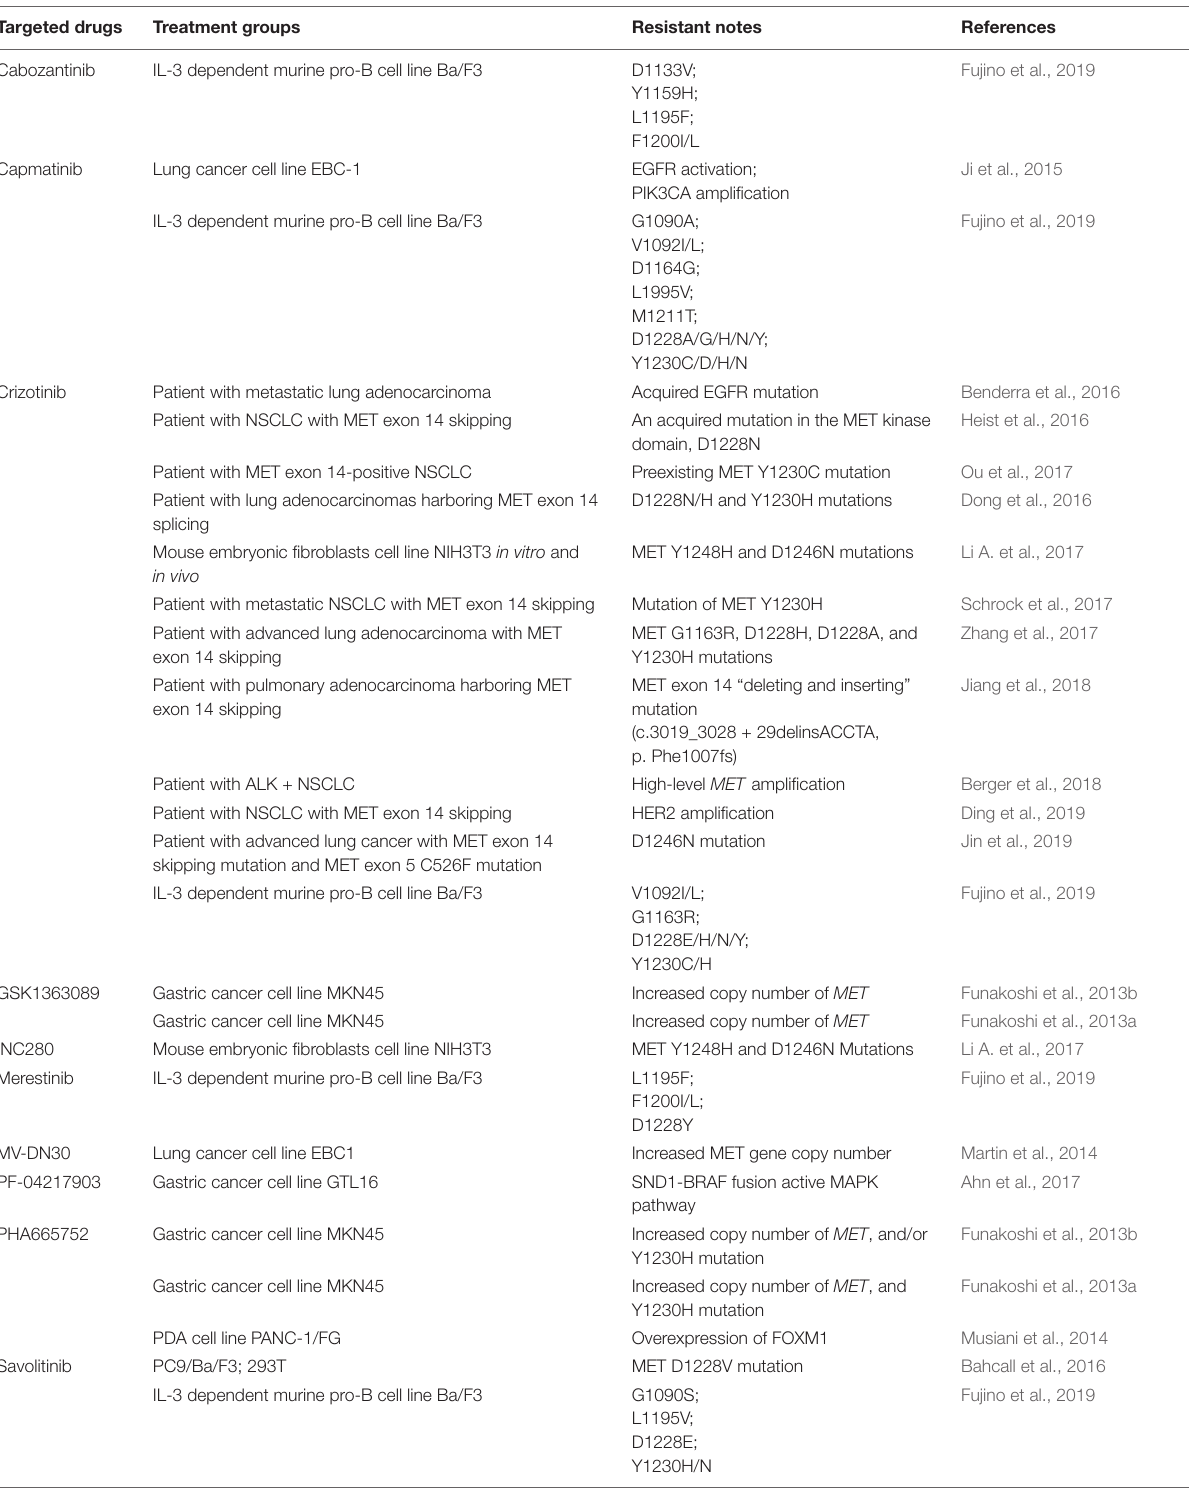
TABLE 1 | Link between MET alteration and therapeutic